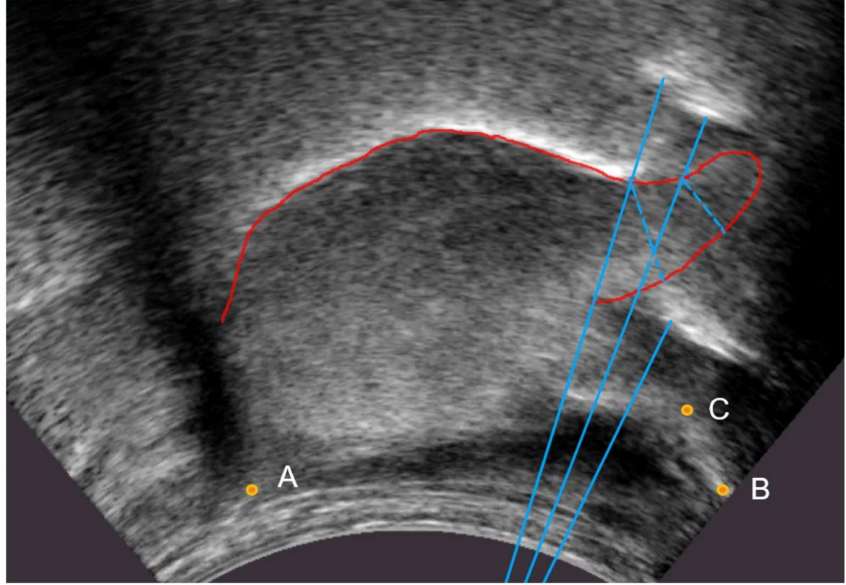
Figure 4. Ultrasound image with beam tracing (blue) showing actual path of ultrasound beam (dotted) and the resulting bright artefacts based on the equivalent time of travel in the direction of the transmitted beam (solid). A—hyoid; B—mandible base; C—short tendon base. Hyoid, mandible base, and short tendon base are indicated in Figure 4 as points A, B, and C,